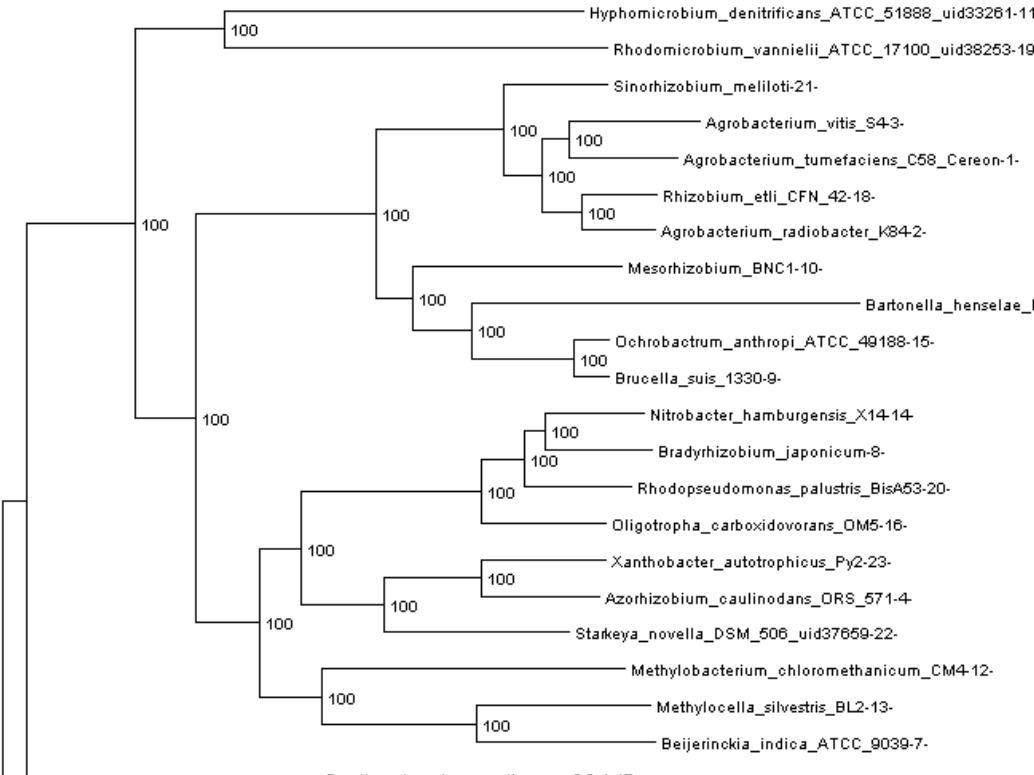
Figure 3. Rhizobiales phylogenomic species tree. The numbers shown at each branching are bootstrap score computed by RAxML [16] based on 100 runs. All numbers are 100, which indicates that this is a robust phylogenetic